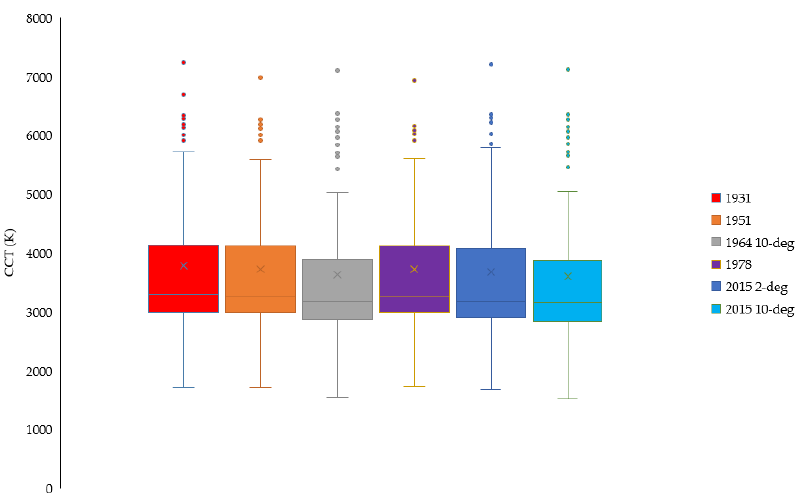
Figure 5. The box plot of CCTs for six CMFs: 1931 (red), 1951 (orange), 1964 10-degrees (gray), 1978 (purple), 2015 2-degrees (blue), 2015 10-degrees (cyan).